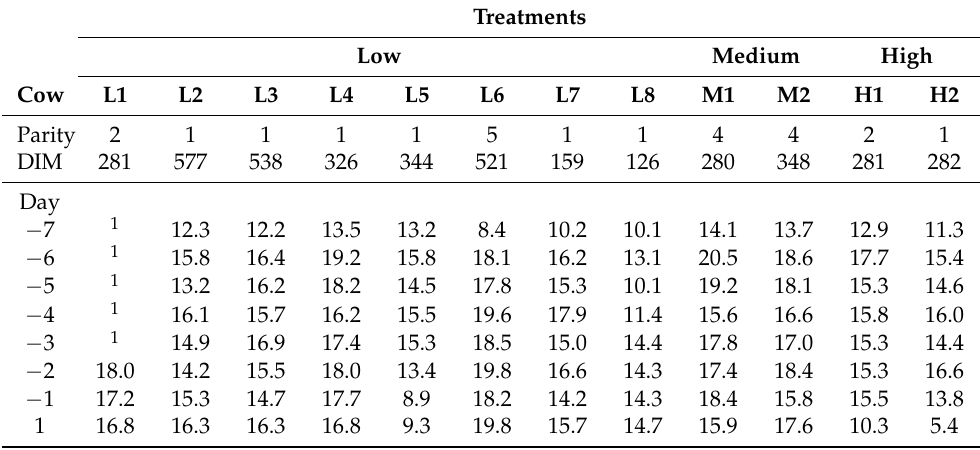
Table 4. Individual dry matter intake (kg/d) during the experiment, and parity and days in milk (DIM) of the dairy cows at the start of the experiment (day − 7 relative to the first day of offering the seaweed mix containing A. taxiformis